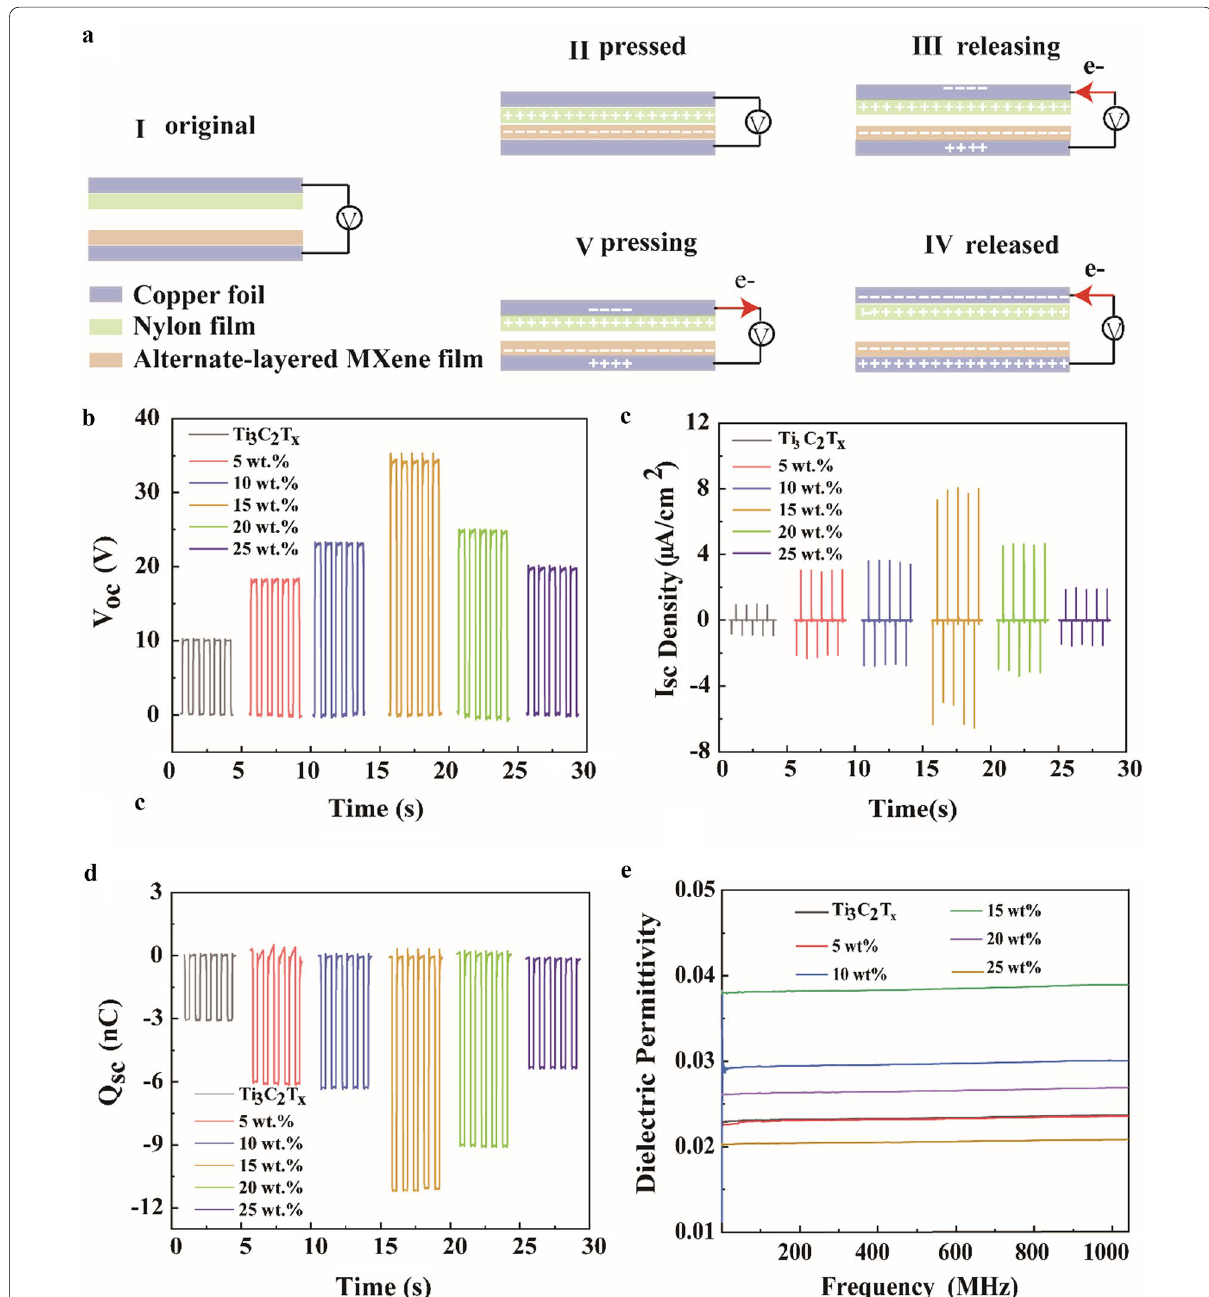
Fig. 3 a Schematic diagram of AM-TENG in contact-separation working mode. b V oc , c I sc density, and d Q sc signals of AM-TENG with different Nb 2 CT x contents at 2 Hz. e Dielectric constant of alternate-layered MXene composite nanosheet films with different Nb 2 CT x